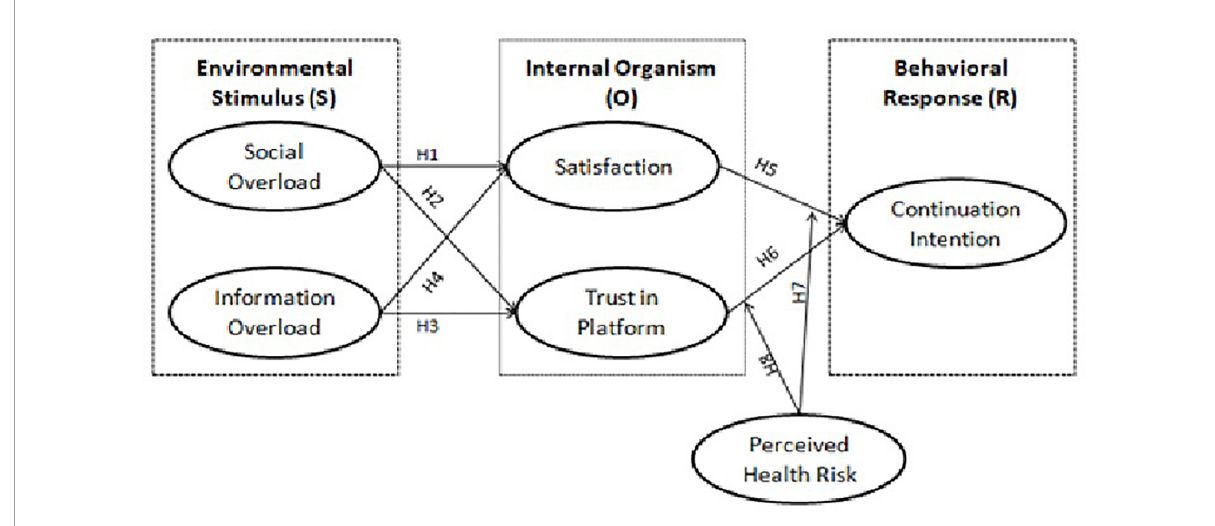
FIGURE1 The theoretical framework of